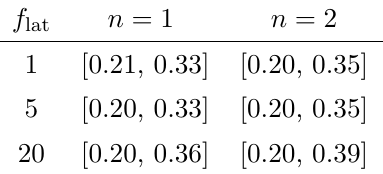
Table 4 . 95% CL upper and lower bounds on R coefficients included from eq. (5.10) and the systematic lattice uncertainty f lat